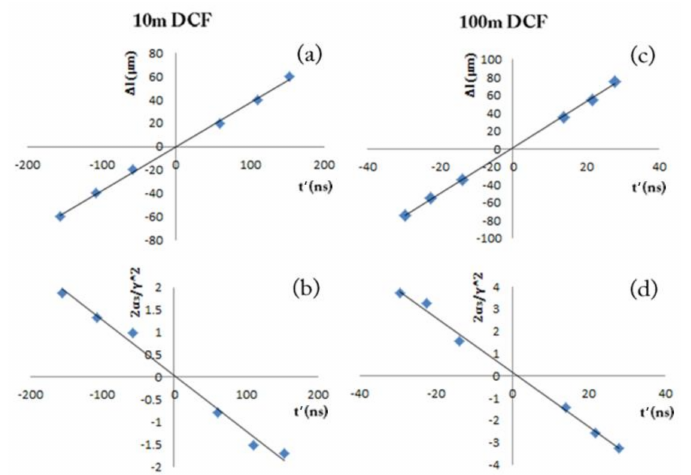
Figure 5. The measurement of the dispersion of 10 m and 100 m DCF. ( a ) The relationship between the optical path difference ∆ l and t (cid:48) of 10 m DCF, the linearity between ∆ l and t (cid:48) is 0.999; ( b ) the relationship between the resolution expansion and t (cid:48) of 10 m DCF, the linearity between α 3 and t (cid:48) is 0.99. ( c ) The relationship between the optical path difference ∆ l and t (cid:48) of 100 m DCF, the linearity between ∆ l and t (cid:48) is 0.999; ( d )the relationship between the resolution expansion and t (cid:48) of 100 m DCF, the linearity between α 3 and t (cid:48) is